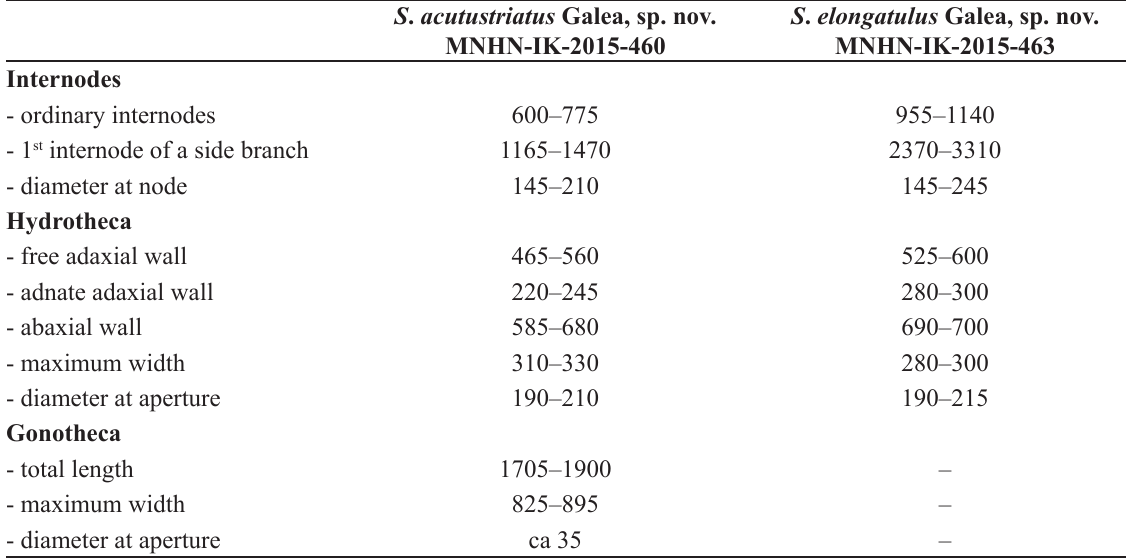
Table 8. Measurements of Symplectoscyphus spp., in